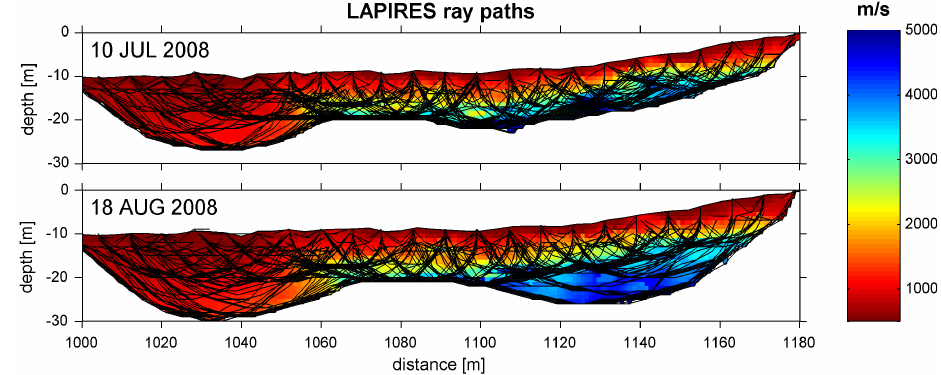
Fig. 12. Calculated ray paths for the tomograms for Lapires from 10 July 2008 and 18 August 2008.